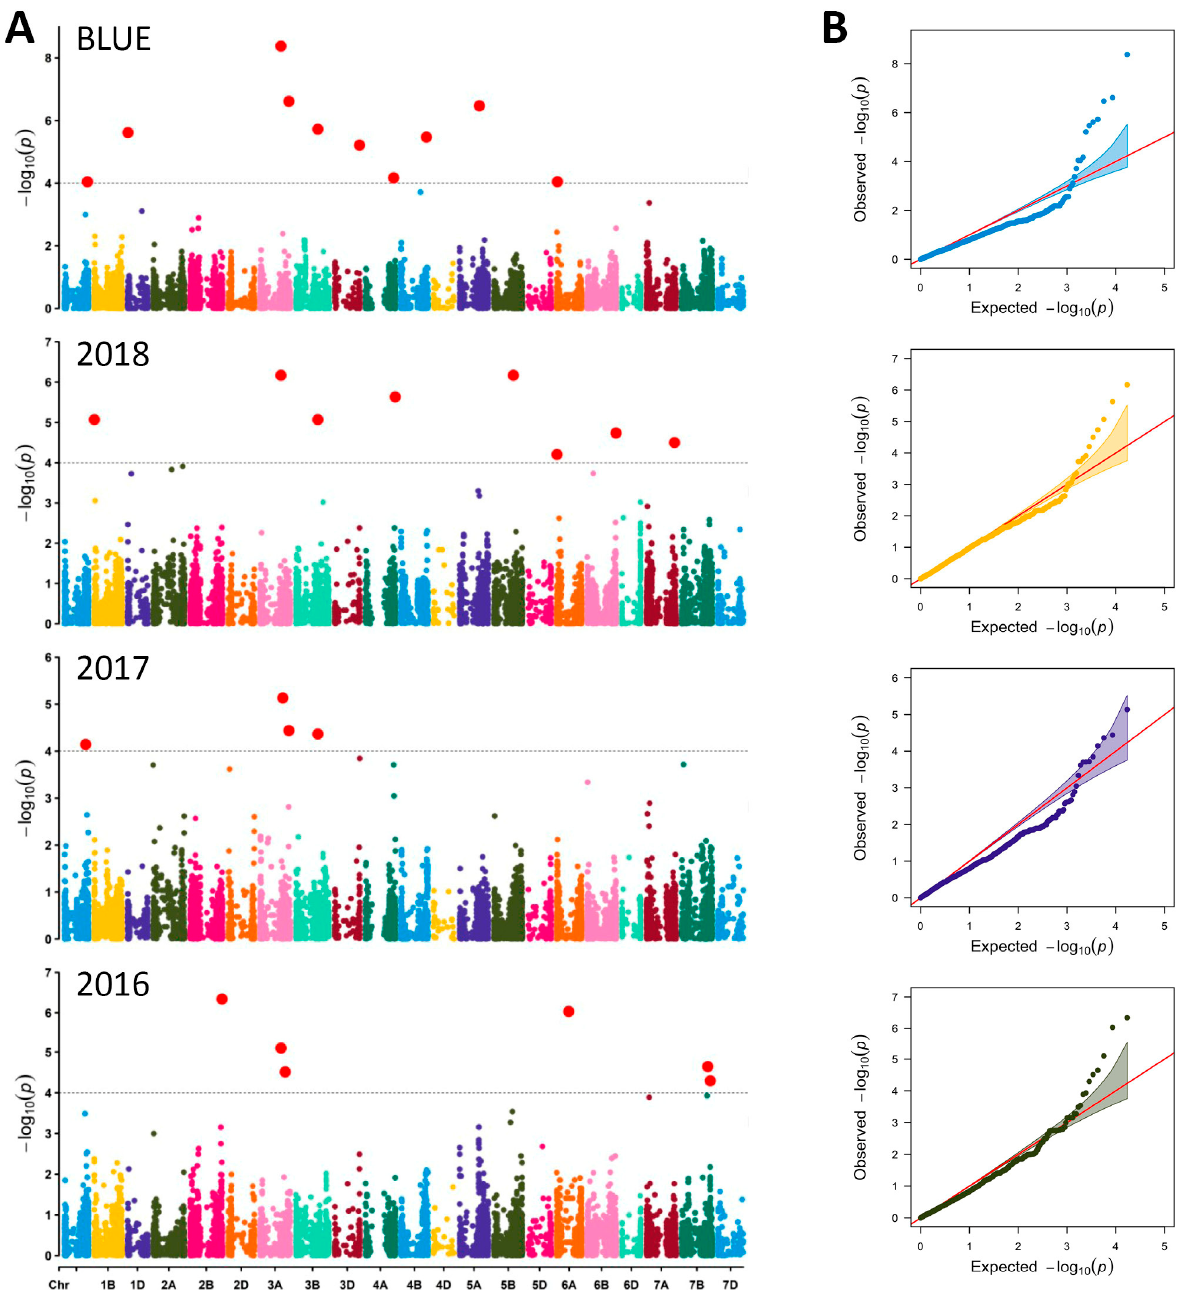
Figure 4. ( A ) Manhattan plots of genome-wide association study for GPC in 255 bread wheat accessions in three growing seasons (2016, 2017, 2018) and BLUEs based on FarmCPU model. The grey color line in the figure corresponds to the threshold of − log 10 ( p < 0.001) = 4.2. The significant quantitative trait nucleotides (QTNs) are above the grey color line; ( B ) quantile–quantile plots of GPC; red line depicts the expected values.